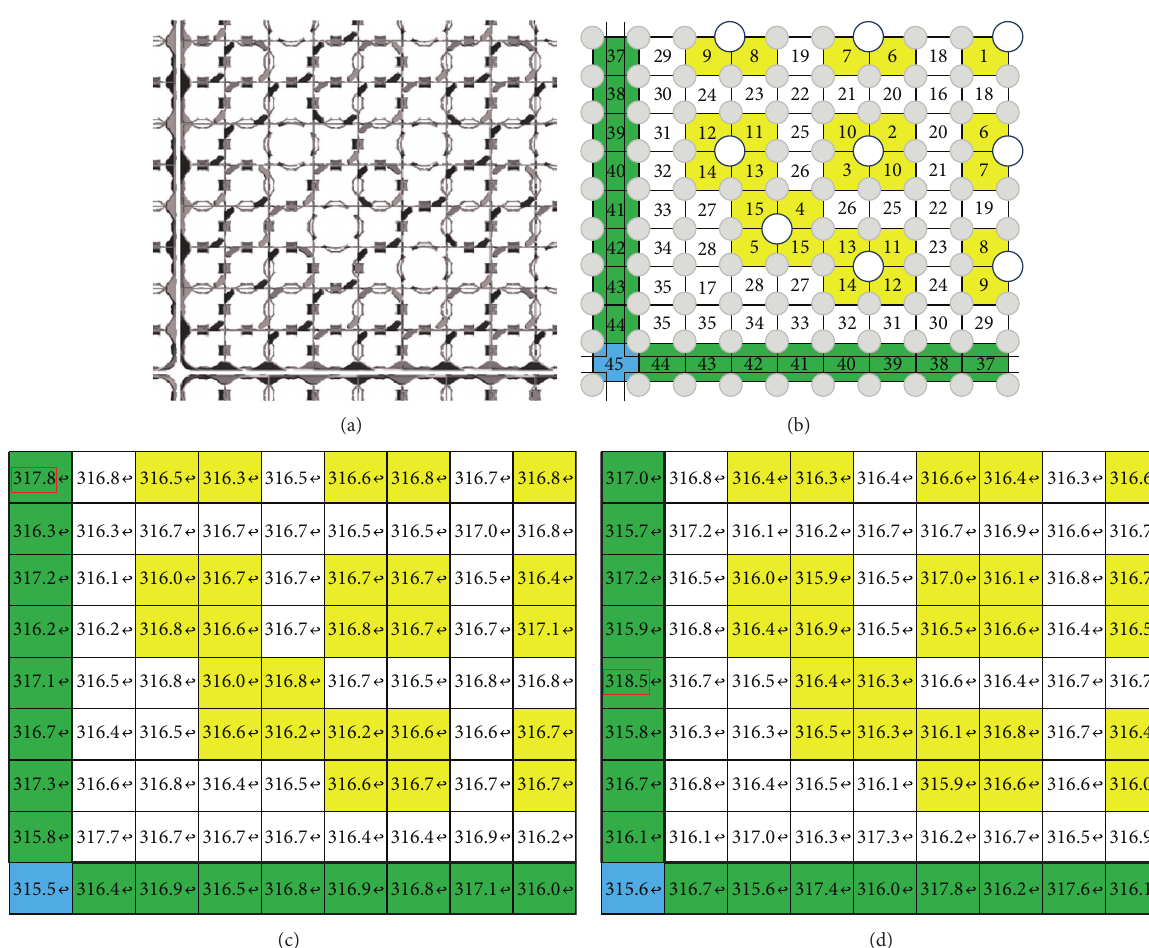
Figure 9: Subchannels outlet temperature: (a) outlet location; (b) subchannel numbering; (c) Design 1 temperature, CFX result; (d) Design 2 temperature, CFX